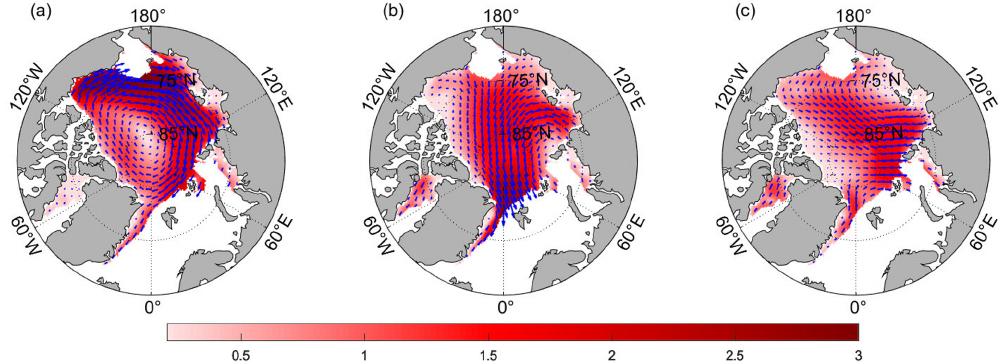
Figure 5. The characteristic vectors for the EOF-based first pattern (a) , the second pattern (b) and the third pattern (c) of the Arctic sea ice motion in winter from 1979 to